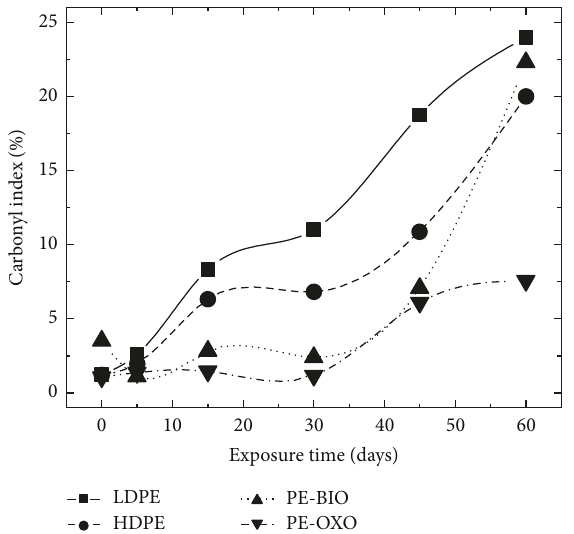
Figure2:Carbonylindex( 𝐼 CO )oftheLDPE( ◼ ),HDPE( e ),PE-BIO ( 󳵳 ), and PE-OXO ( 󳶃 ) films exposed to UV-B radiation.